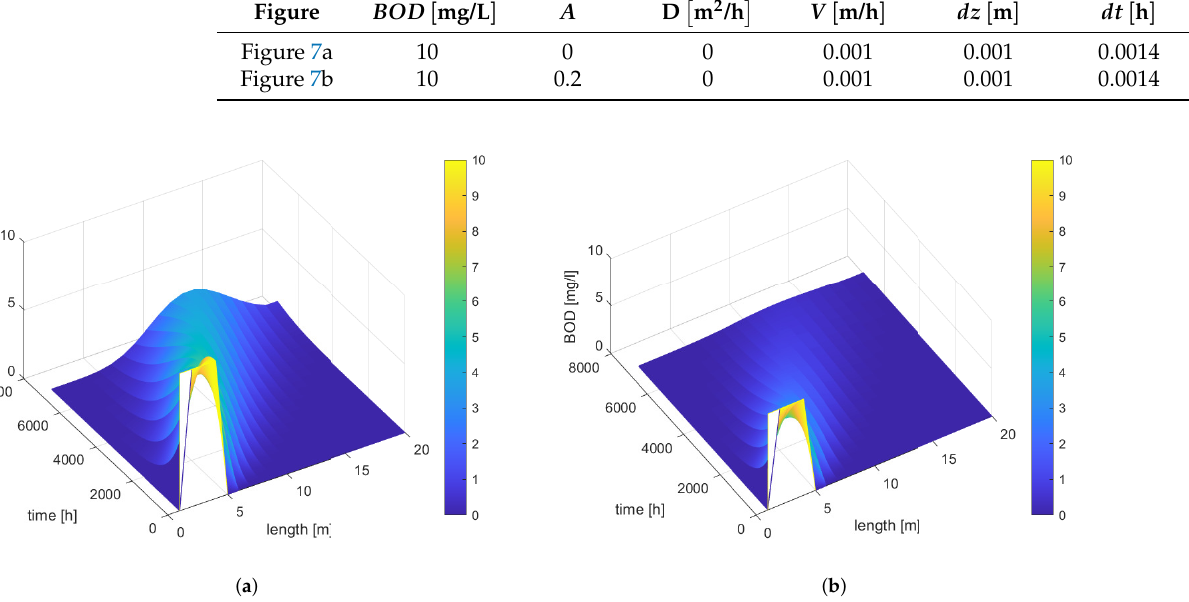
Figure 7. BOD distribution excluding the self-cleaning process ( a ) and including the self-cleaning process ( b